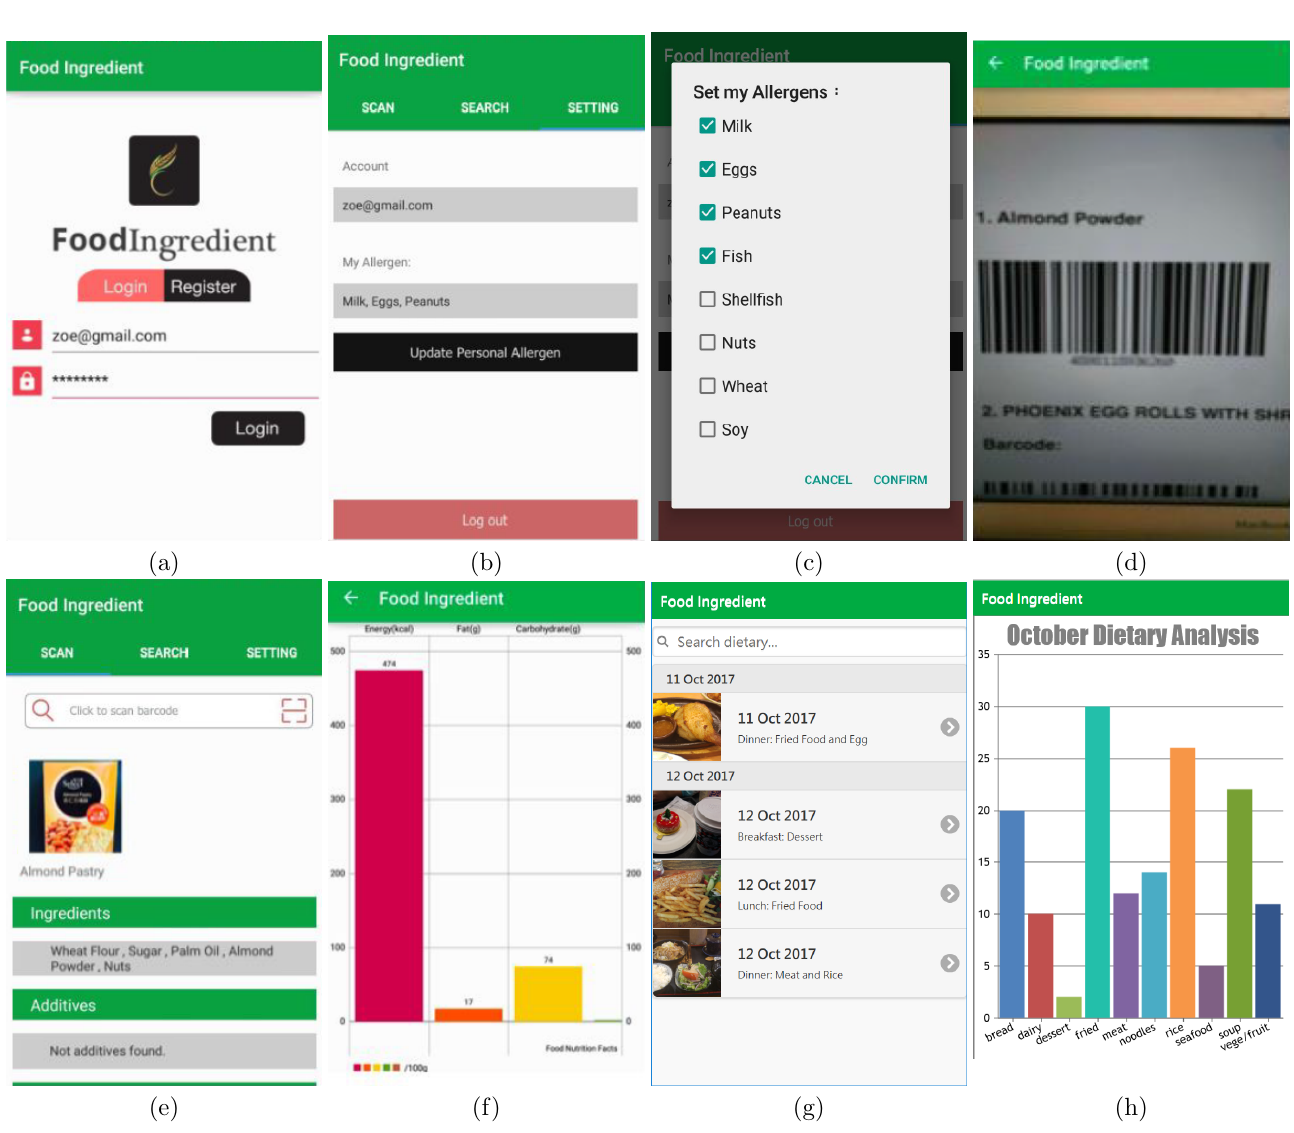
Figure 3. The user interface of our mobile application, including a) user login page, b) account settings, c) allergen selection, d) scanning of barcode or photo taking, e) food ingredient details, f) nutrition details, g) list of dietary records and h) dietary